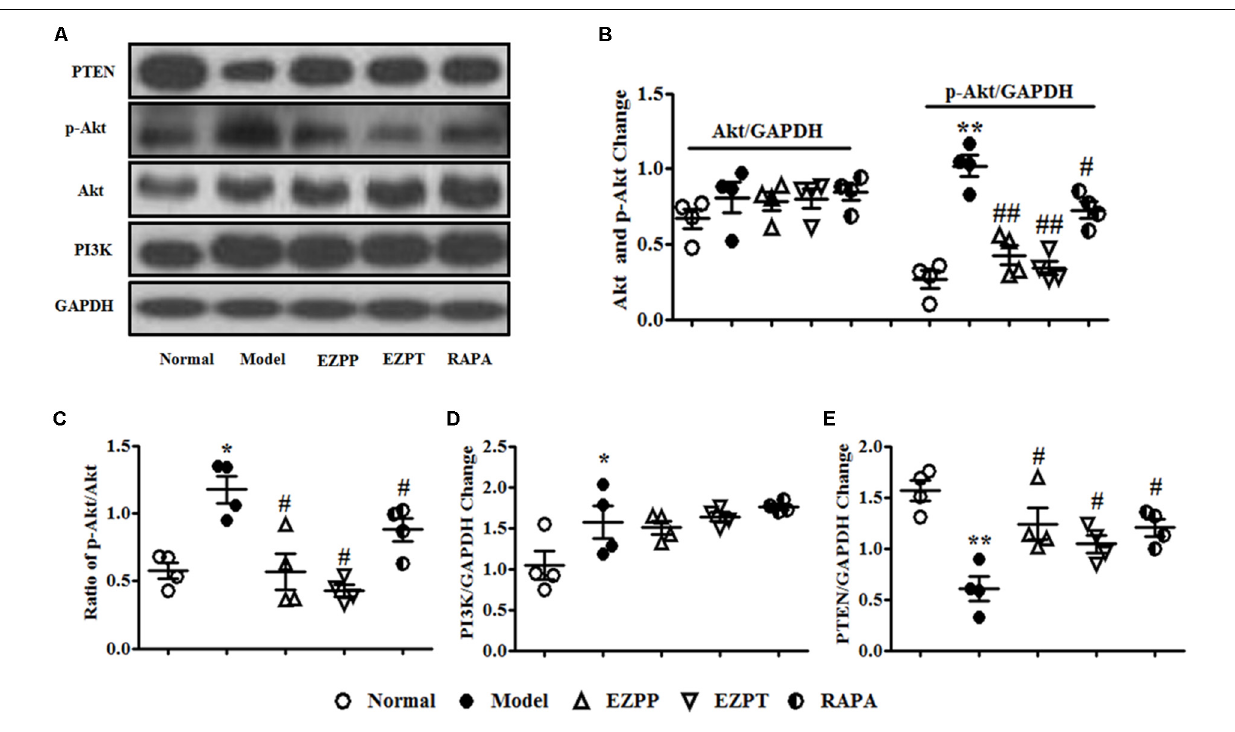
FIGURE 6 | Western blotting of PI3K, Akt, and PTEN. (A) Western blotting of PI3K, Akt, p-Akt, and PTEN. (B) Quantitative analysis of Akt and p-Akt. (C) Ratio of p-Akt/Akt. (D) Quantitative analysis of PI3K. (E) Quantitative analysis of PTEN. Data are presented as mean ± SEM ( n = 3). ∗ p < 0.05 and ∗∗ p < 0.01 versus Normal group; # p < 0.05 and ## p < 0.01 versus Model